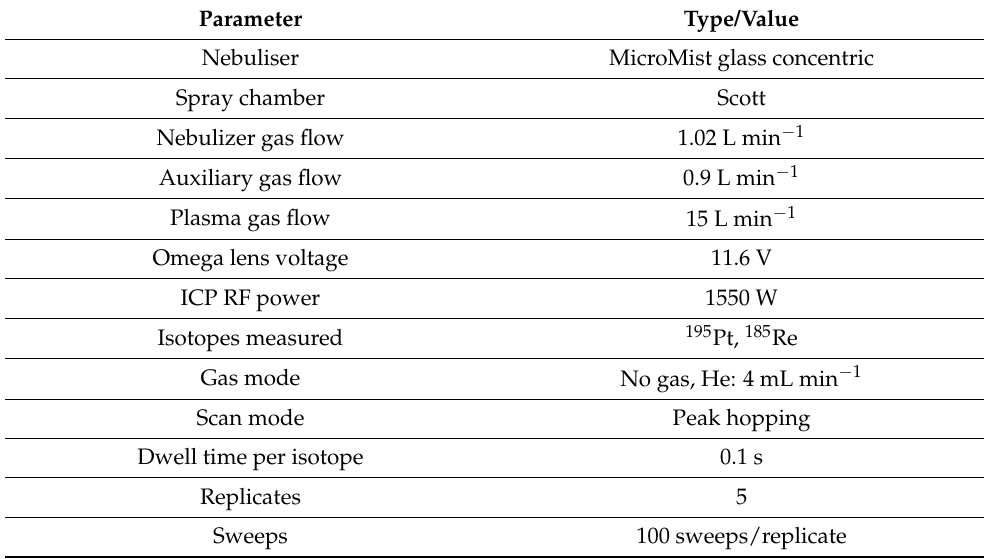
Table 2. Operating parameters of the